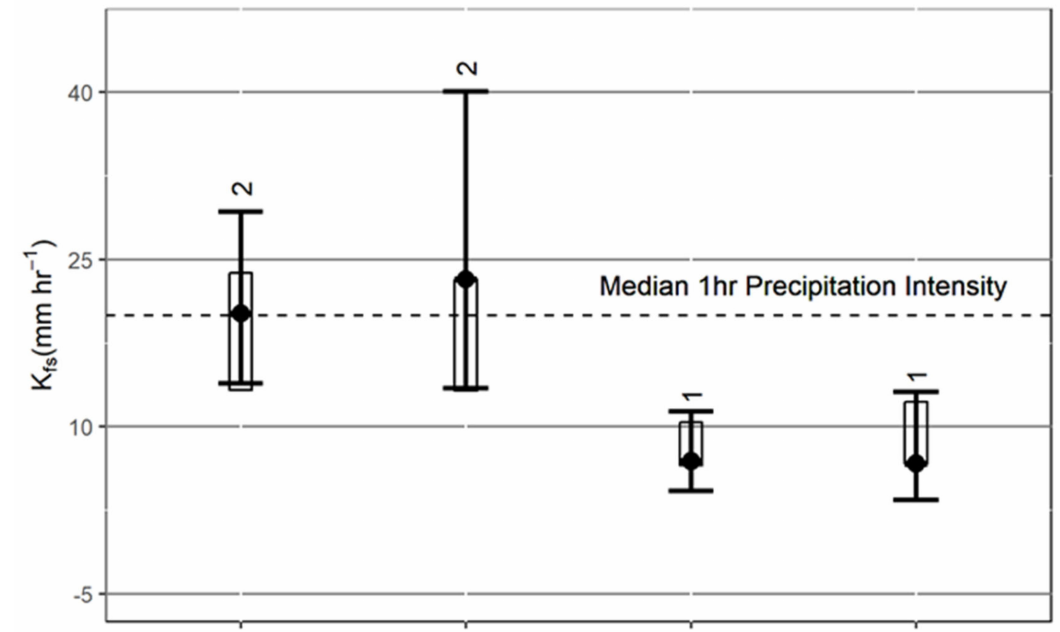
Figure 4. Estimated marginal means for the different land cover types. Error bars represent 95% confidence intervals. Crossbars that overlap are not significantly different. p values adjusted using the Tukey method for comparing a family of four estimates. Significance level used was alpha = 0.05. Plantation refers to teak plantations. The median 1 h precipitation intensity for the Jabalpur weather station from the Surface Integrated Dataset it plotted to assist